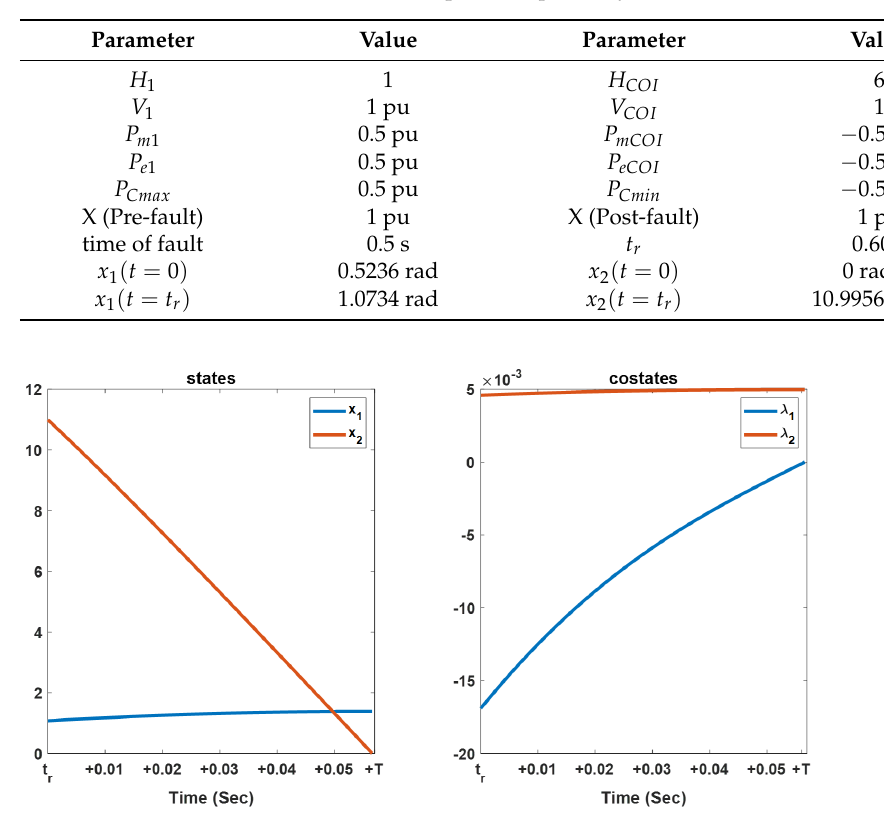
Table 2. Parameters for the two-machine equivalent power system.